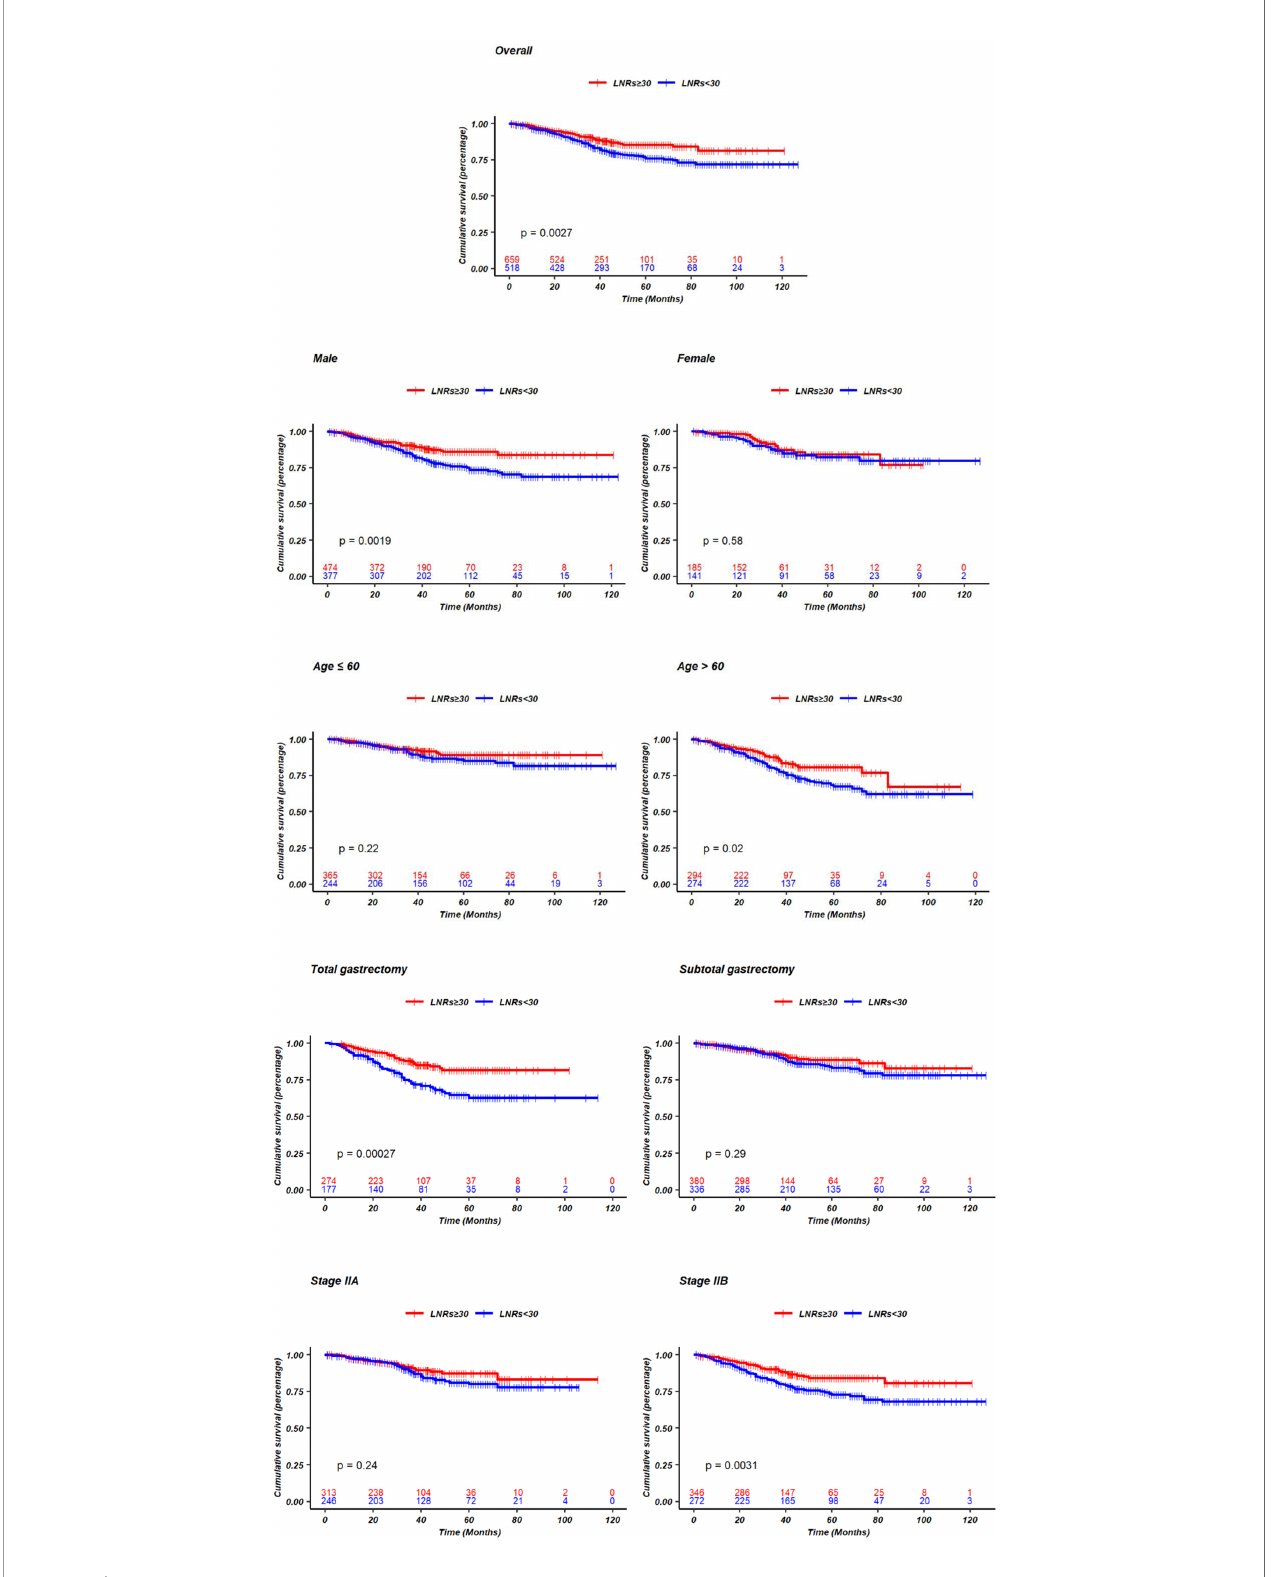
FIGURE 5 | Kaplan-Meier curves of survival comparing LNRs <30 and LNRs ≥ 30 strati fi ed by sex, age, extend of gastrectomy, different pTN stage.